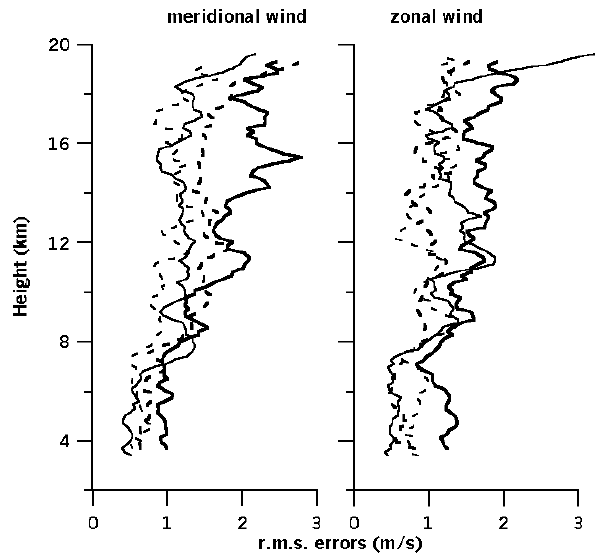
Fig. 1. Vertical profiles of rms deviations (errors) in hourly averaged meridional (left panel) and zonal winds (right panel) for the autumn equinox (thin line), winter (thick dashed line), vernal equinox (thin dashed line) and summer (thick line)